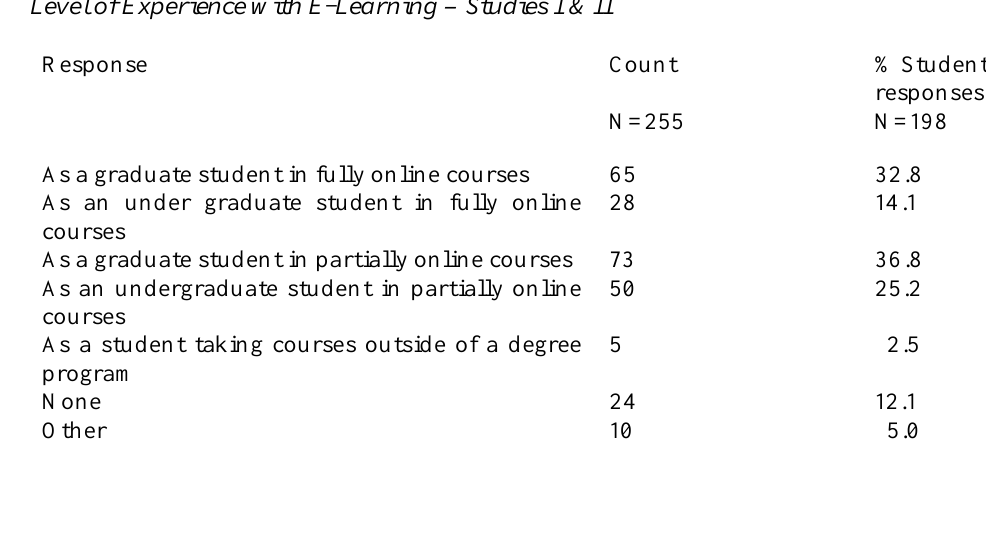
Level of Experience with E-Learning – Studies I & II